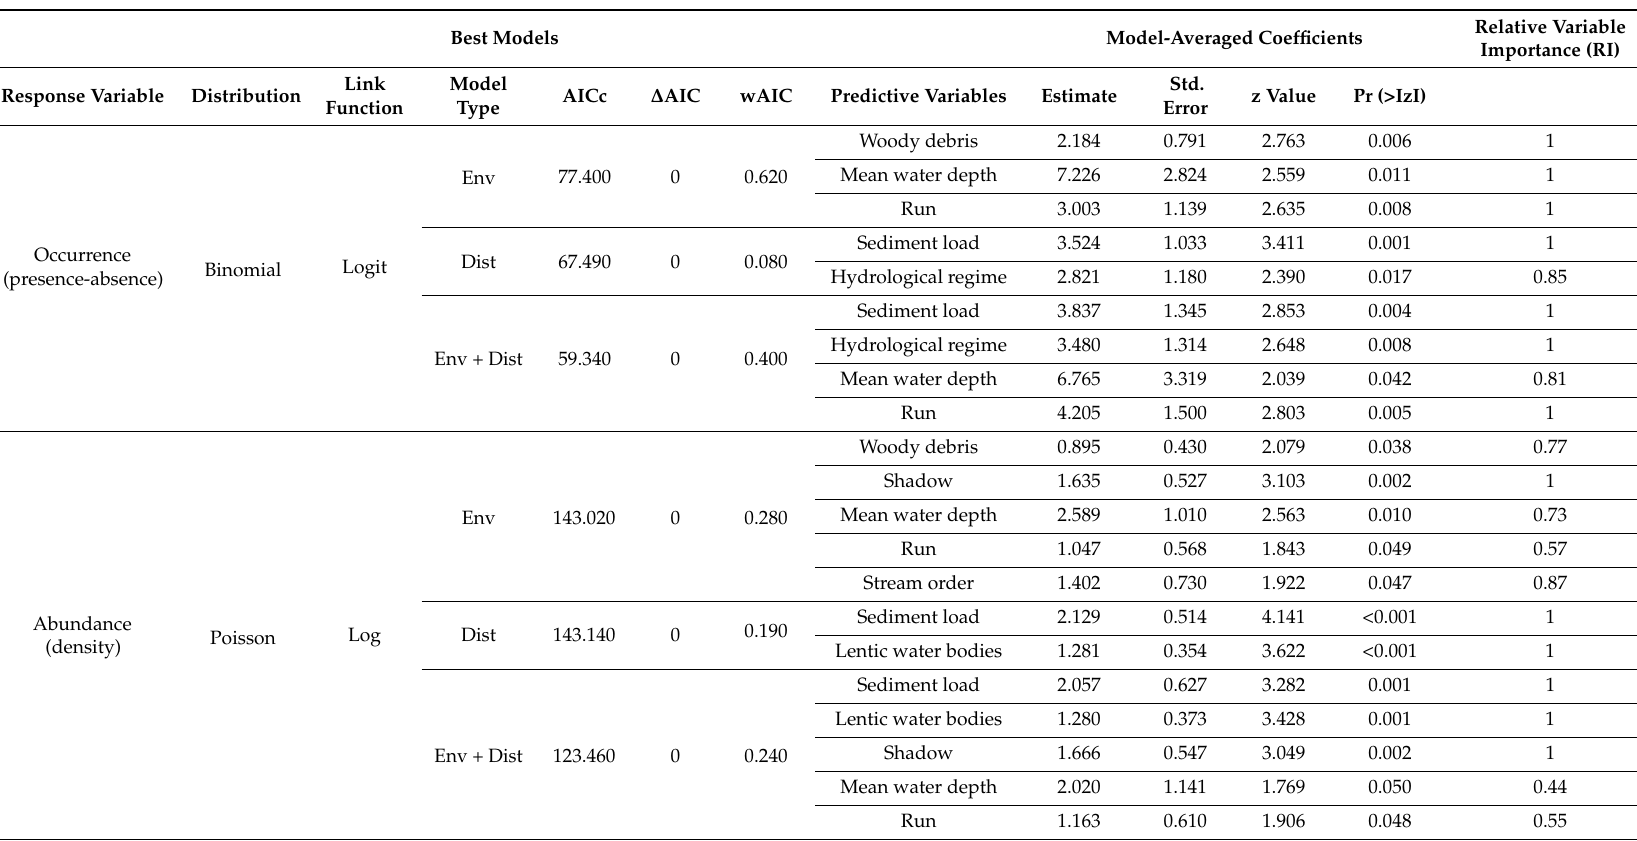
Table 1. Summary of model selection ( ∆ AIC < 4) for predicting the occurrence and abundance of Alburnus alburnus including different sets of variables (model type): environmental (ENV), anthropogenic disturbance (Dist) and combined effects (Env + Dist). For the best model of each type, the Akaike’s information criterion (AICc), the difference of AIC between each model and the best model ( ∆ AIC) and the Akaike weight (wAIC) are registered. Outputs of the averaged coefficients (including the best models summing wAIC >0.9) and the relative importance of the significant predictive variables are also